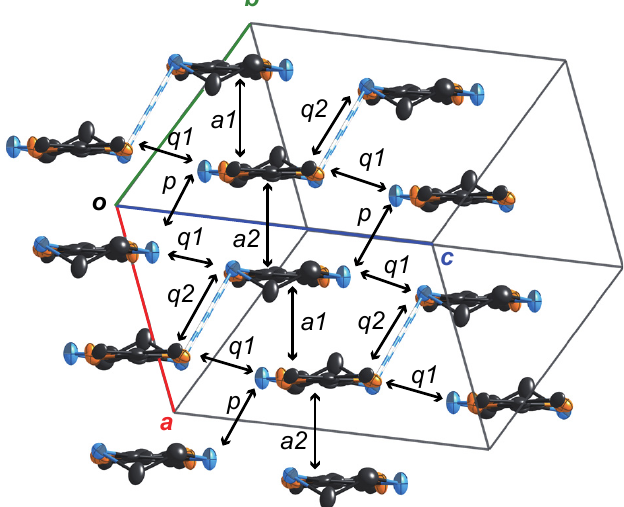
Figure 10. Molecular arrangement viewed along the molecular long axis. The calculated overlap integrals (×10 − 3 ) are a 1 = − 2.04, a 2 = 21.47, p = 0.05, q1 = 0.80, and q2 = 22.04. The hydrogen atoms are omitted for clarity.